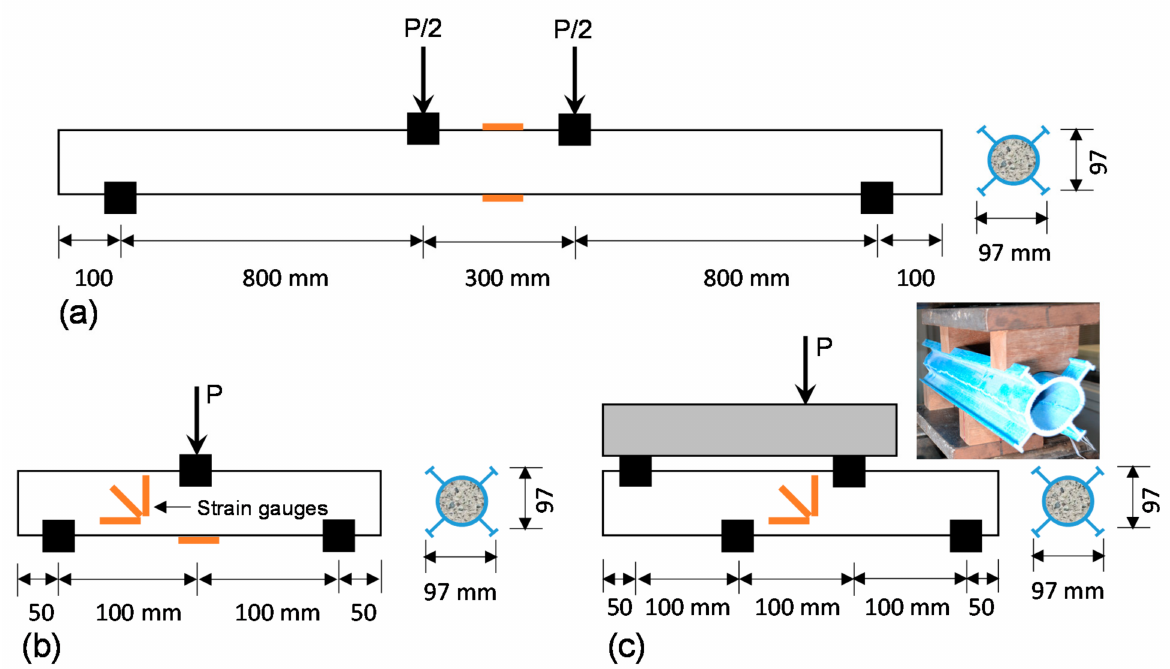
Figure 3. Test setup: ( a ) four-point bending (FPB), ( b ) short beam shear (SBS) and ( c ) asymmetrical beam shear